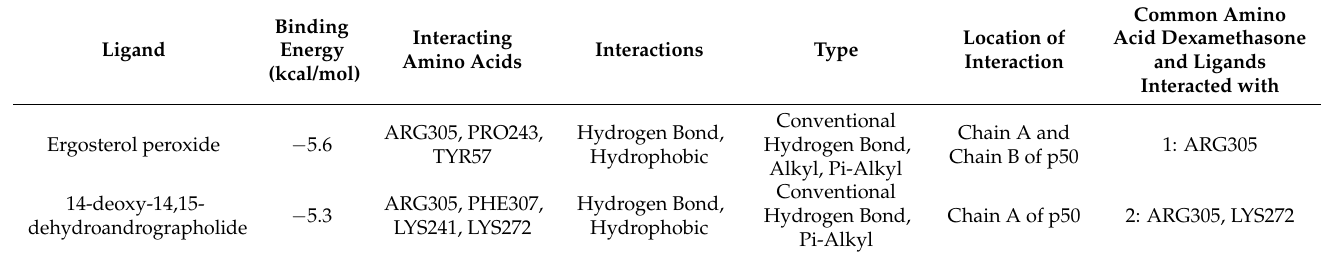
Table 7. Interactions between the binding ligands with lowest binding energies and NF- κ B p50.